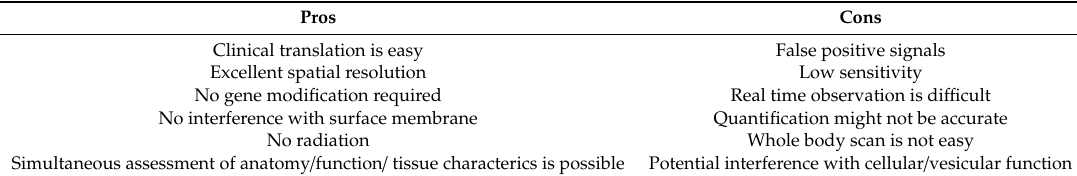
Table 1. Pros and cons of superparamagnetic iron oxide (SPIO)